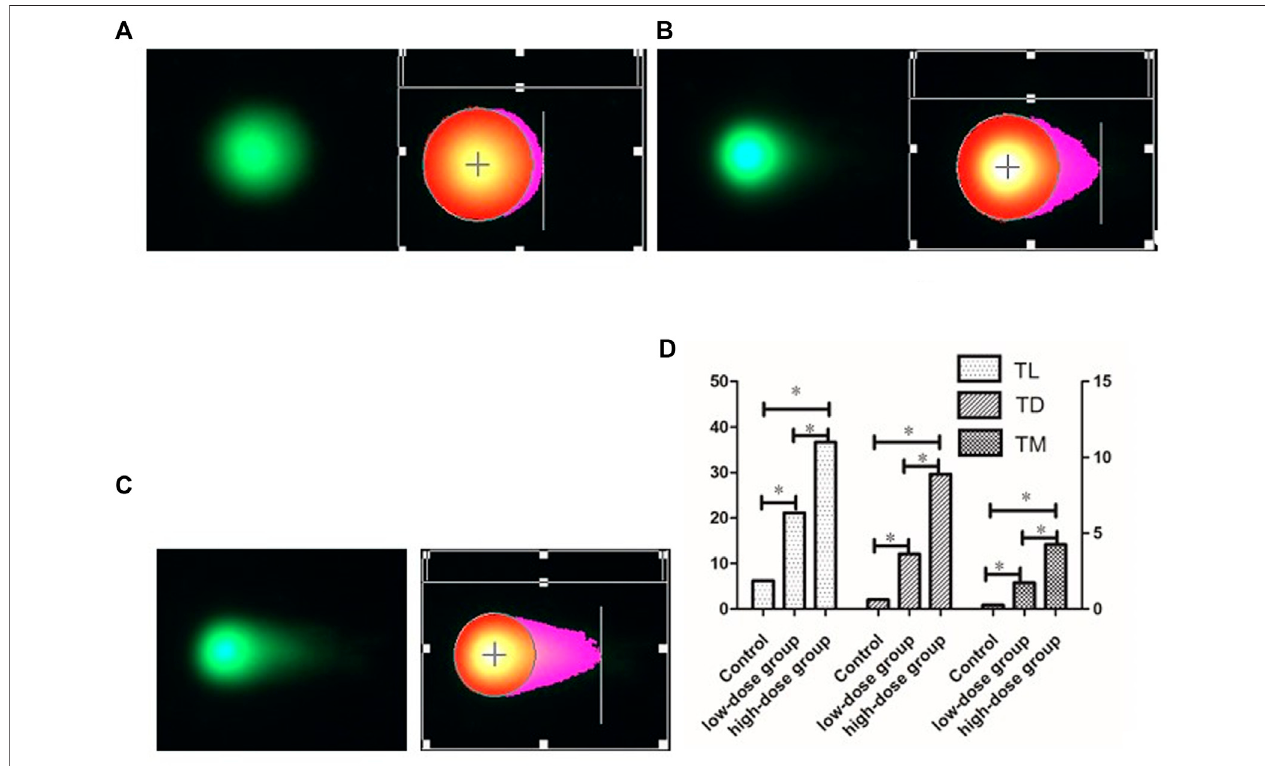
FIGURE 1 | comet images of BMCs DNA damage at different dose of PM2.5. (A) :Control (0 mg/ml) (20 × ). (B) :low-dose group (0.1 mg/ml) (20 × ). (C) :high-dose group (0.2 mg/ml) (20 × ). (D) : Comet assessment of BMCs DNA damage by PM2.5, including TL, TD, TM. p p < 0.05.